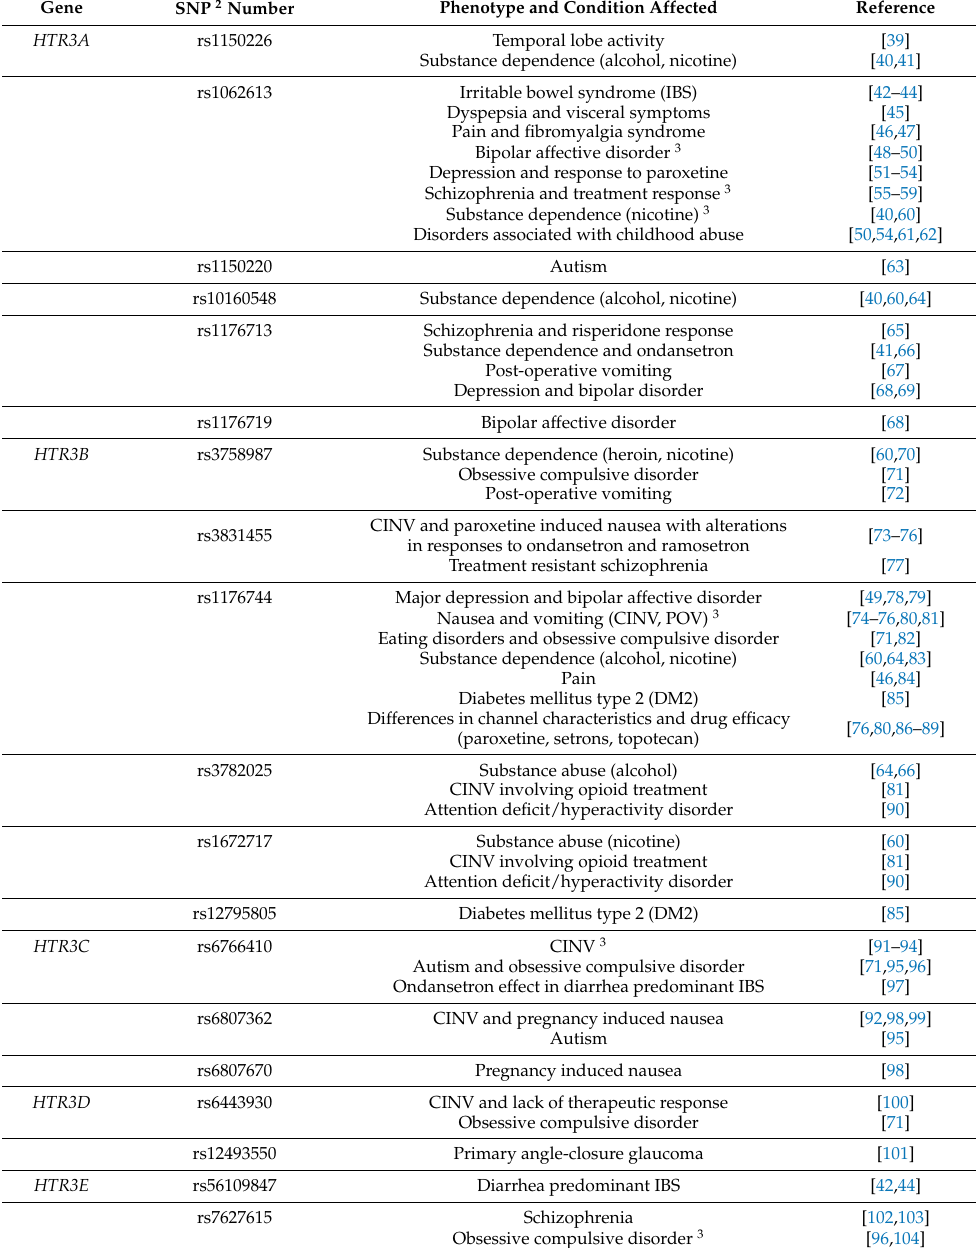
Table 1. Summary of disorders related to mutations of HTR3 genes encoding 5-HT 3 receptor subunits 1